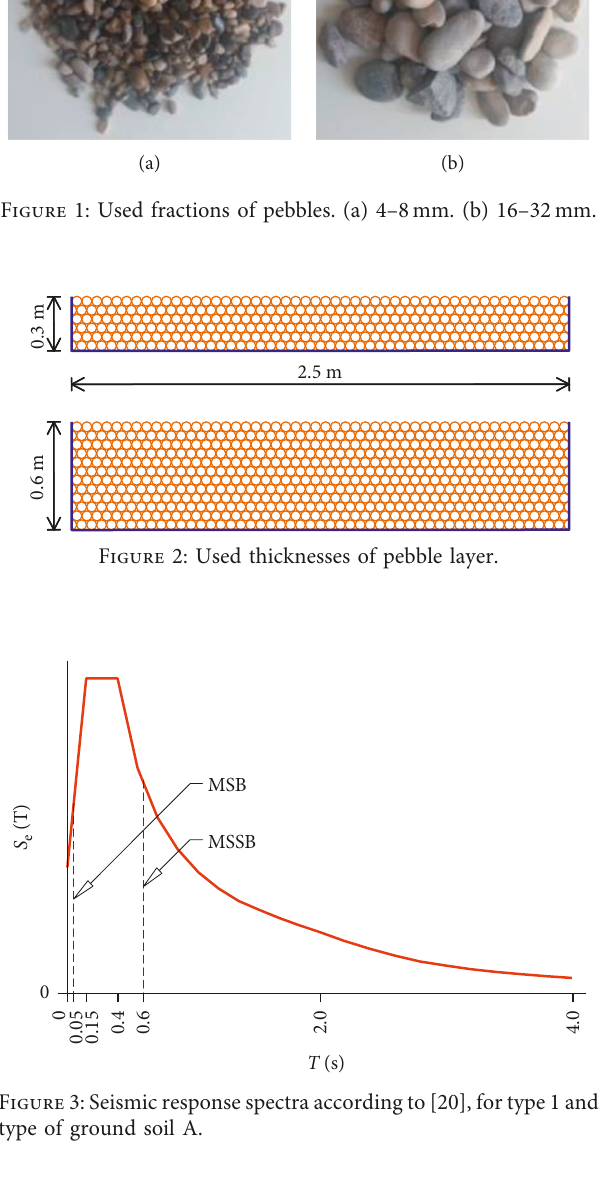
Figure 3: Seismic response spectra according to [20], for type 1 and type of ground soil A.